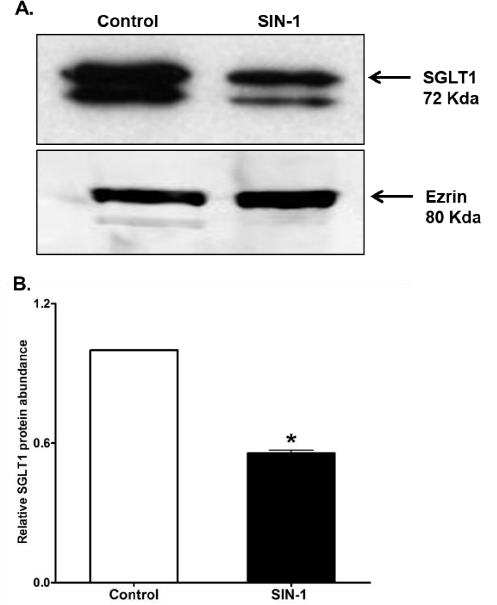
Figure 7. Effect of peroxynitrite on SGLT1 protein expression. ( A ) Representative Western blot of SGLT1 protein expression that is significantly diminished by SIN-1 in IEC-18 cells. ( B ) Densitometry analysis showed that SGLT1 proteins levels are significantly diminished when treated with SIN-1 compared to the control. (n = 3; * p < 0.001). Control is assigned a value of 1, and the SIN-1 value is relative to the control. Error bars when not visible are inclusive in the